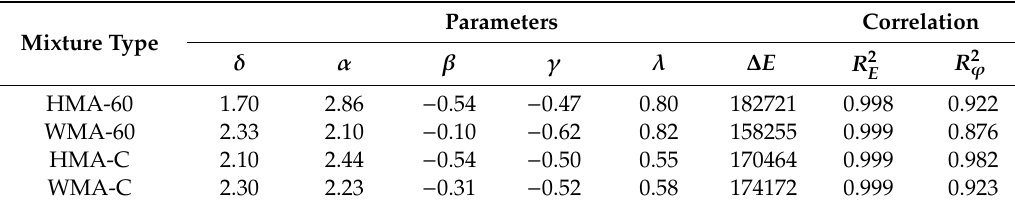
Table 6. Fitting parameters of the GSM (Arrhenius equation).